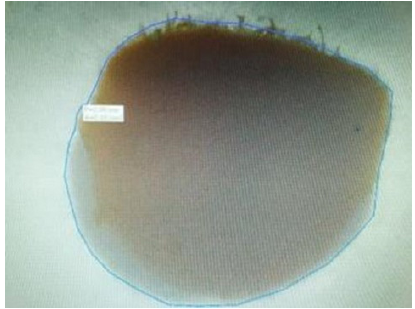
Figure 2. Perimeter measurement.